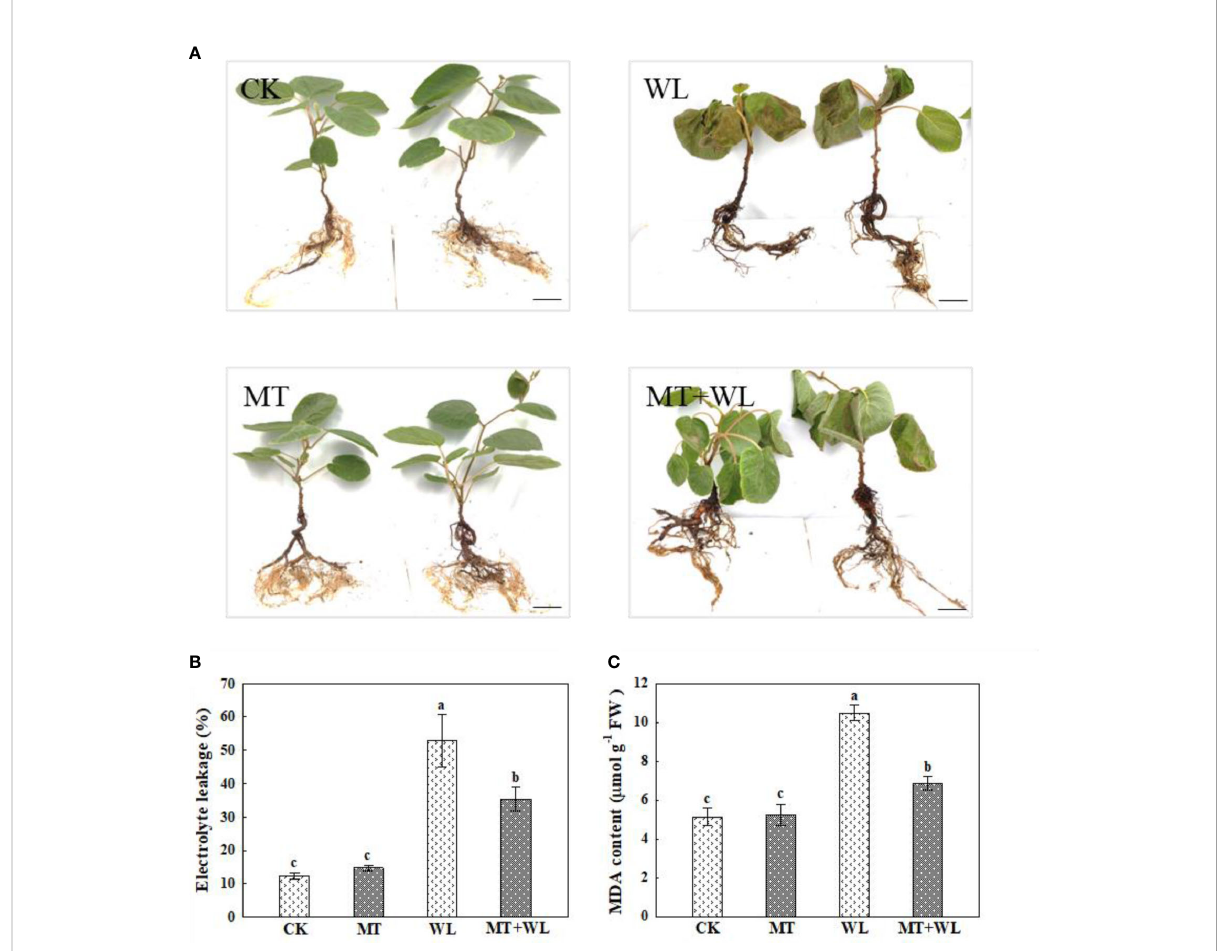
FIGURE 1 Exogenous melatonin alleviated the waterlogging damage on kiwifruit plants. (A) Phenotypes of kiwifruit plants in control (CK), melatonin treatment (MT), waterlogging treatment (WL), and melatonin and waterlogging treatment (MT+WL) groups, and the plants in WL and MT+WL groups were being waterlogged for 9 days. Bars: 5 cm. (B) Relative electrolyte leakage (REL) and (C) malondialdehyde (MDA) concentration of plants in CK, MT, WL, and MT+WL groups. Data are shown as the means of three replicates with SEs. Different letters indicate signi fi cant differences between treatments, according to one-way ANOVA and Tukey ’ s multiple range test (P <